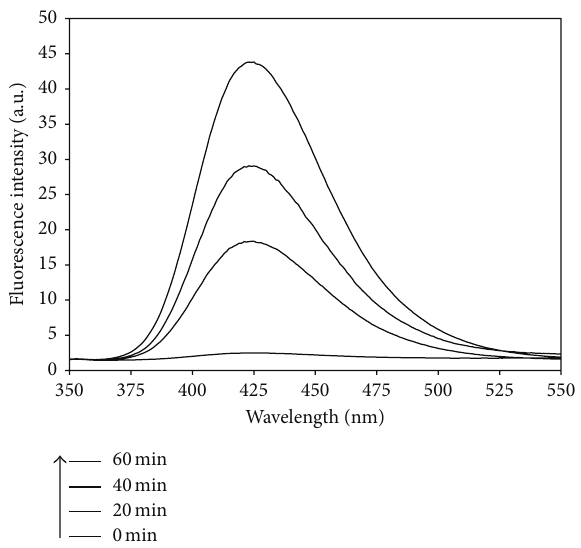
Figure 4: Photoluminescence spectral changes observed during irradiation of the Pt/WO 3 sample. (Experimental conditions: NaOH concentration of 2 × 10 −3 M, terephthalic acid concentration of 5 × Figure 5: Photoluminescence intensity of pure WO 3 and modified −1 , and simulated solar 10 −4 M, Pt/WO WO 3 -based photocatalysts as a function of irradiation time. (Exper- 3 concentration of 200 mg L light intensity of 0.4 mWcm −2 .) imental conditions: NaOH concentration of 2 × 10 −3 M, tereph- thalic acid concentration of 5 × 10 −4 M, catalyst concentration of 200 mg L −1 , and simulated solar light intensity of 0.4mWcm −2 .)